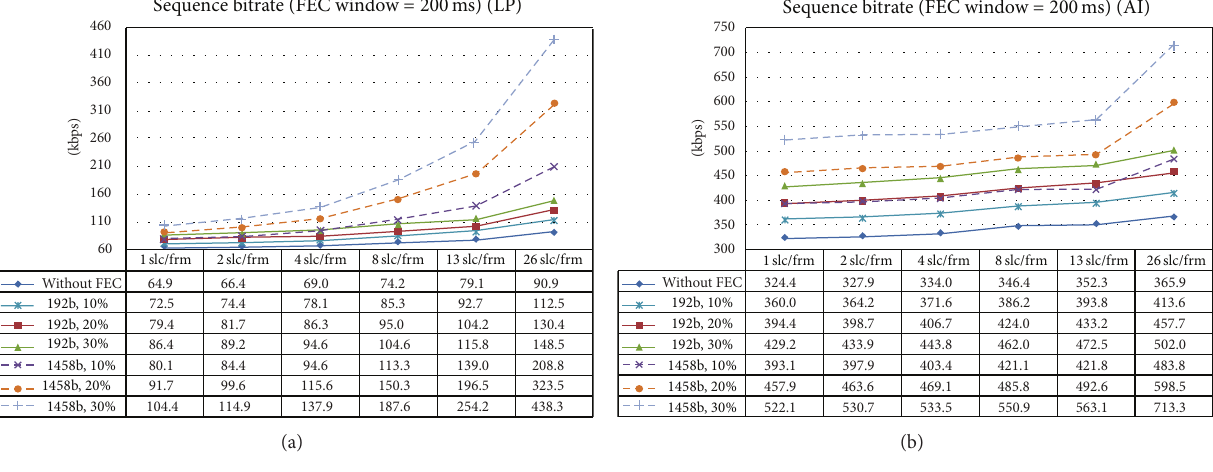
Figure 3: Bitrate (kbps) without FEC protection and with FEC protection for different symbol sizes, different protection windows, and different number of slices per frame (including RTP and fragmentation headers). (a) LP mode. (b) AI